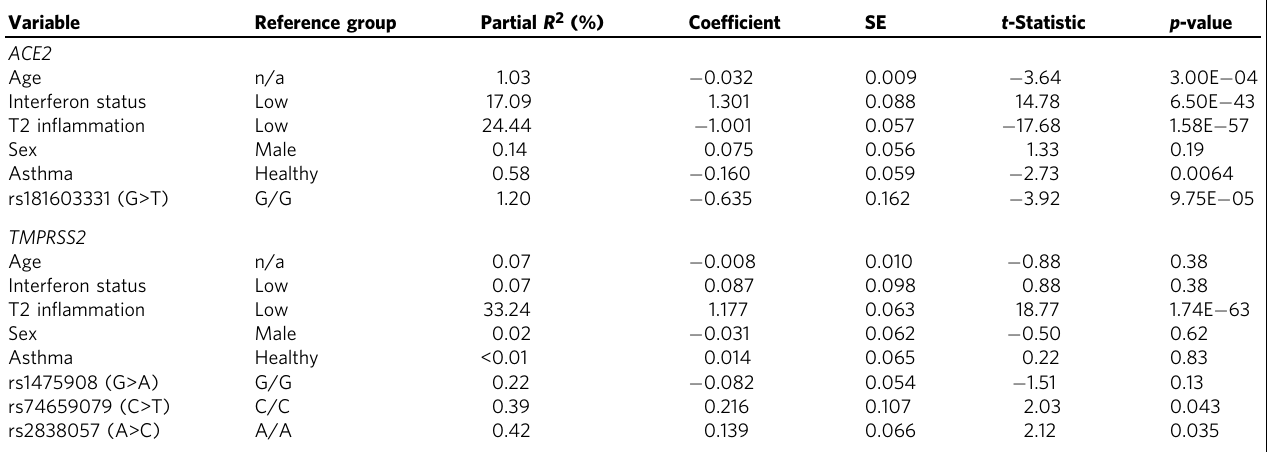
Table 1 Results for multivariate models of ACE2 and TMPRSS2 expression.